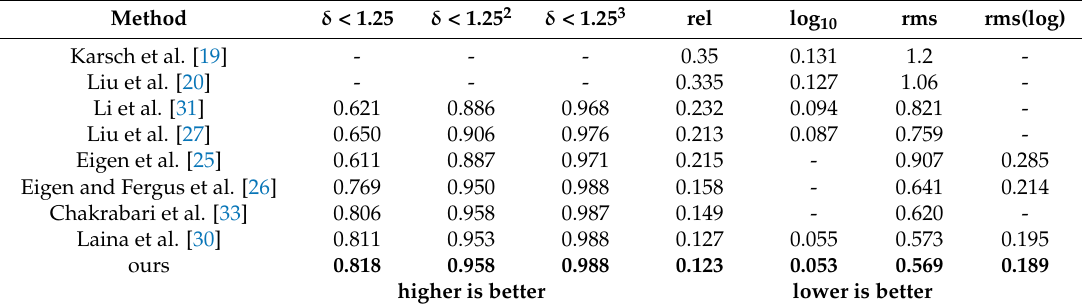
Figure 4. Example depth results. ( a ) RGB image; ( b ) result in Reference [30]; ( c ) our result; ( d ) ground truth. Note that the color range of each image represents the distance of the camera to the object. Table 2. Quantitative comparison with state-of-the-art-based methods on the NYU Depth v2 dataset [18]. For the δ accuracies, higher is better; for the others, lower is better.